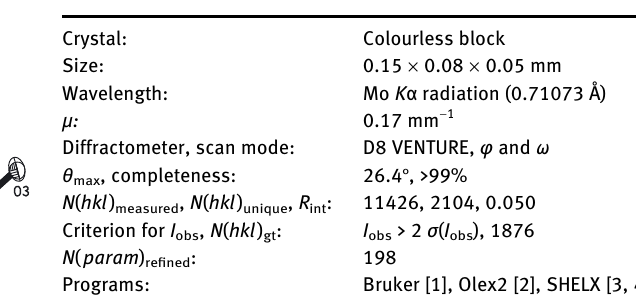
Table  : Data collection and